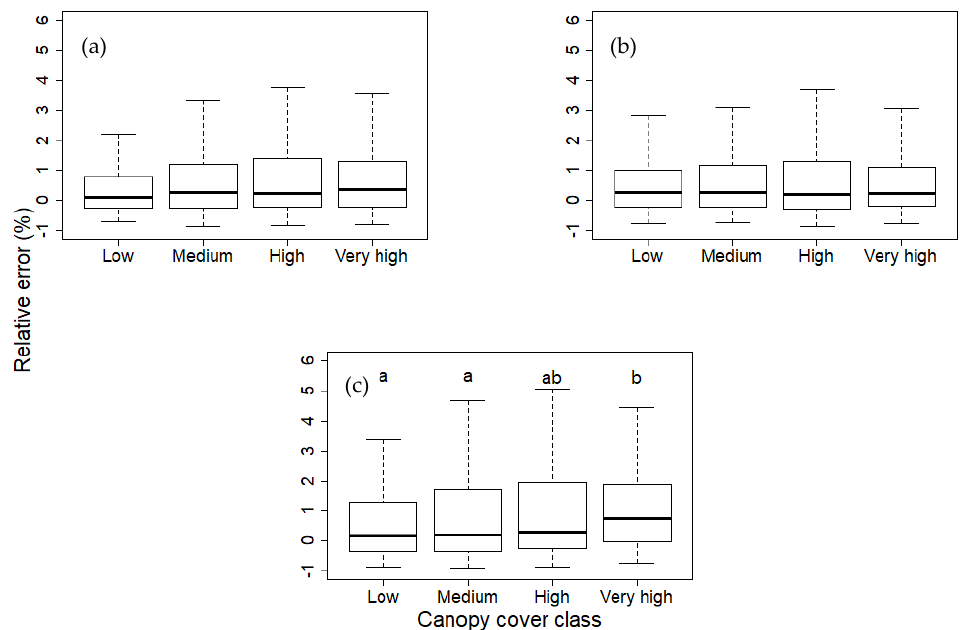
Figure 4. Distribution of the relative error (%; Equation (3)) as a function of canopy cover class (low: 0% to 24%, medium: 25% to 49%, high: 50% to 74%, and very high: ≥ 75%) for models estimating sapling density (stems / ha) of all species. ( a ) Model integrating both sensors, ( b ) model including LiDAR and environmental variables, and ( c ) model including spectral and environmental variables (Kruskal–Wallis test, ( a ) p = 0.30, ( b ) p = 0.92, and ( c ) p = 0.006). The groups a are statistically similar between them and di ff erent from group b, whereas group ab is statistically similar to group a and b.